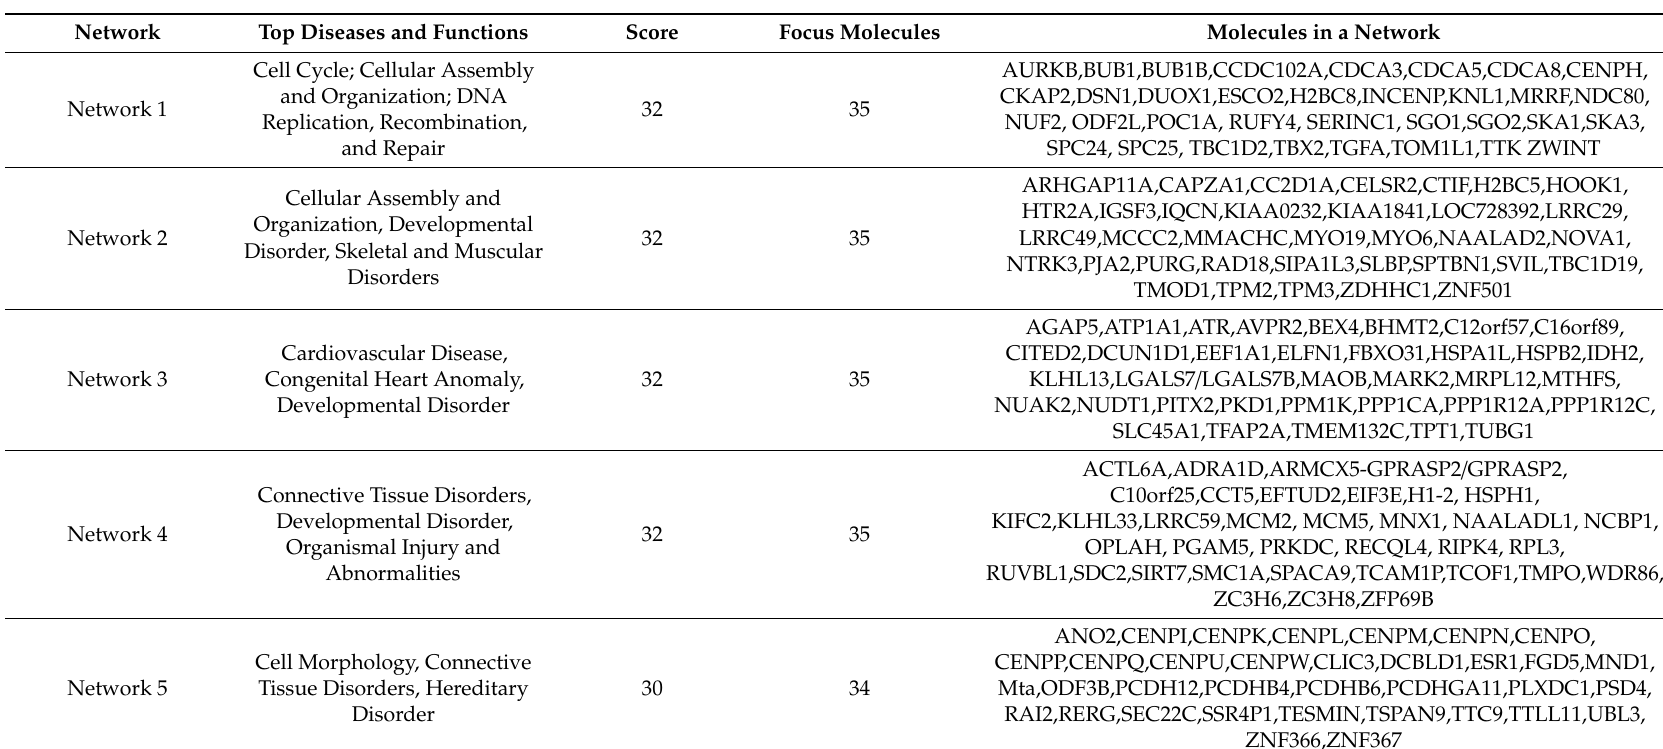
Table 1. List of the top 10 altered networks in CC based on IPA